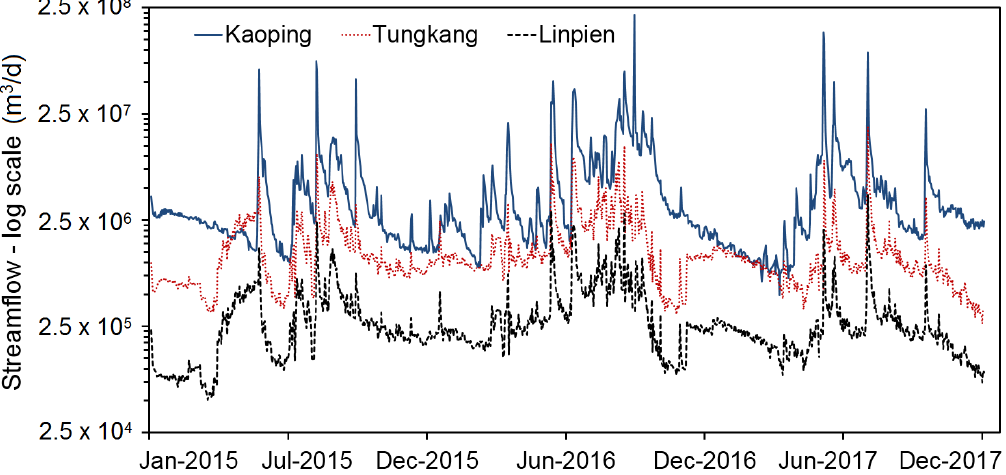
Figure 10. The volumetric flow rates at outlets of the three main rivers in the PPGB.